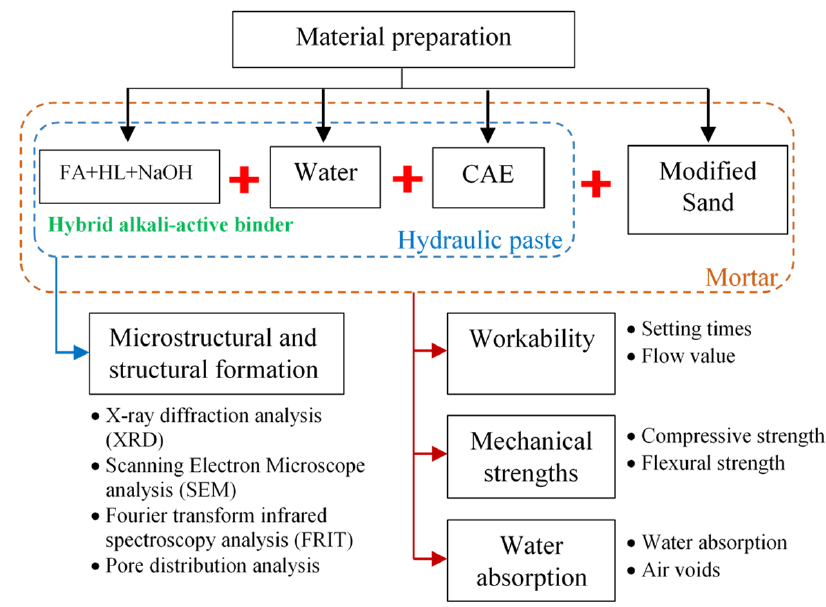
Figure 4. Perspective diagram of the research.